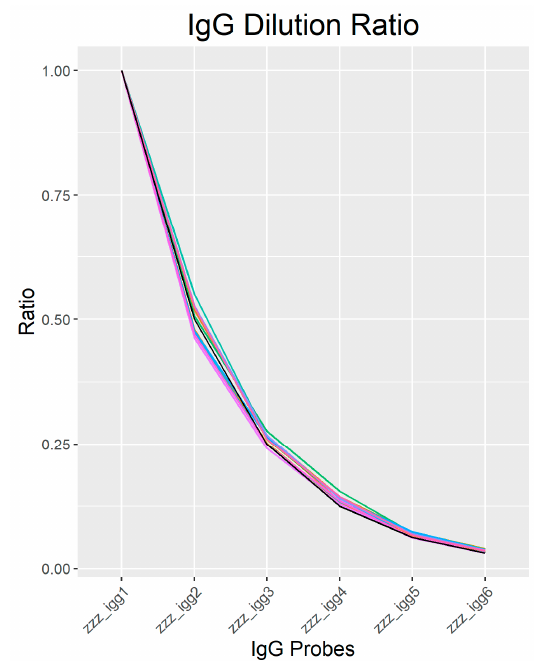
Figure 1. Sengenics-Immunome™ Protein Array quadruplicate images for IgG control spots showing serial dilution (Left to right).